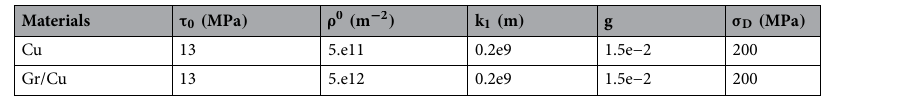
Table 3. The dislocation density hardening parameters of the Cu matrix and the 1 vol.% Gr/Cu composites.